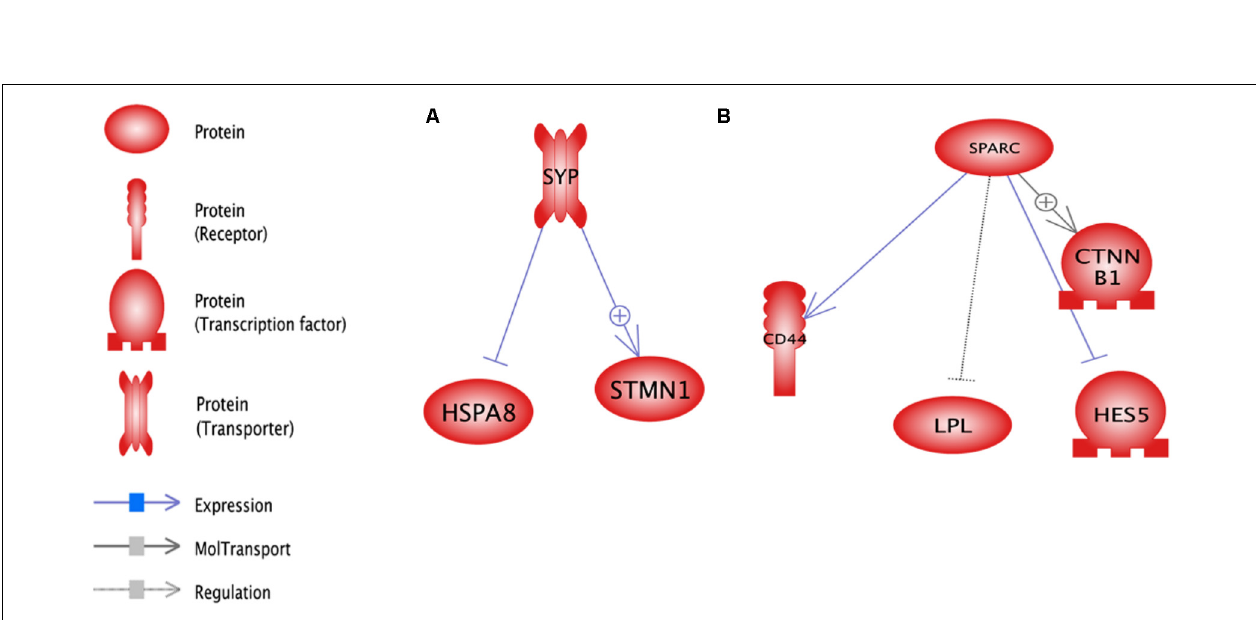
FIGURE 8 | Enriched sub-networks in up-stream neighbors of differentially expressed genes in lactation process; (A) Down-regulated genes, (B) Up- regulated